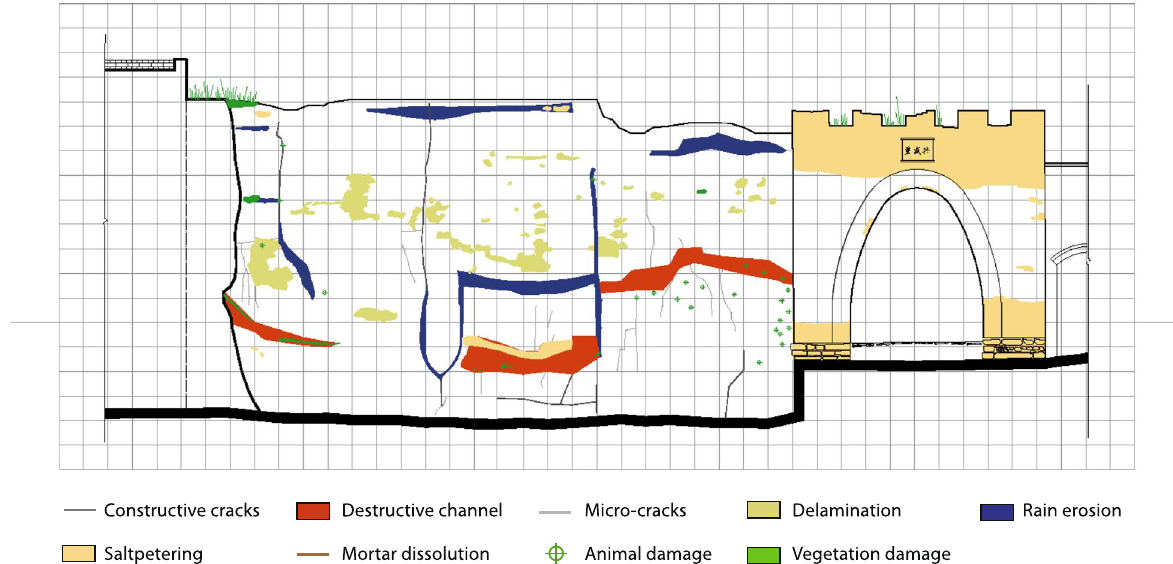
Fig. 16 Pathological analysis of the south facade of the wall (Source: Tongji University, Ecole de Chaillot and China Academy of Art